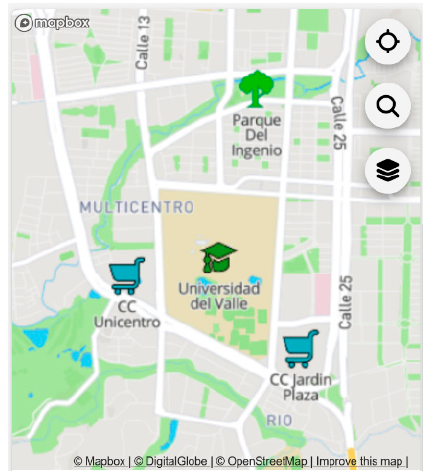
Figure 3. Simple map.